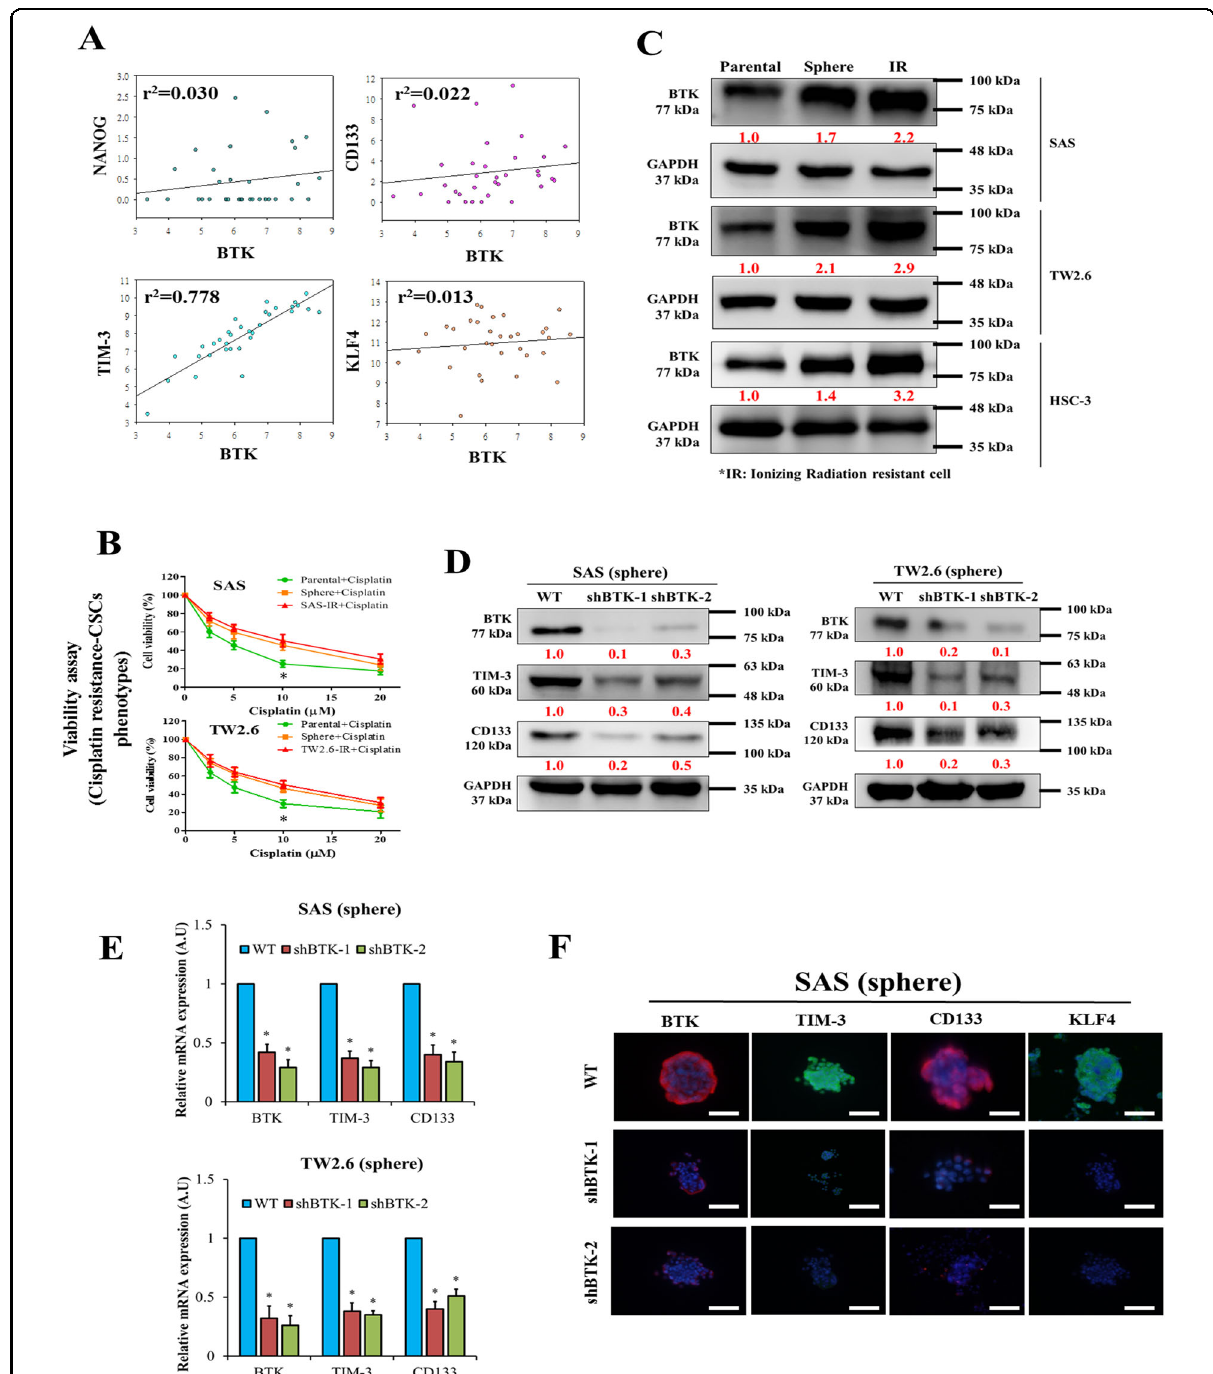
Fig. 2 BTK is positively correlated with radiation-resistant and CSCs-like phenotypes of OSCC. A Scatter plot showing the correlation between the expressions of BTK mRNA and NANOG, CD133, TIM-3, and KLF4. B Cell viability assay revealed higher cisplatin resistance, indicated by sphere and ionizing radiation (IR)-resistant SAS and TW2.6 cells compared with the parental cells. C The protein BTK expression in SAS, TW2.6 and HSC-3 parental, sphere, and IR cell lines as shown by Western blotting. D E Effect of BTK-knockdown on BTK, TIM-3, and CD133 expressions at both mRNA and protein levels. F Immuno fl uorescence staining showing the effect of shBTK on the BTK expression, TIM-3, CD133, and KLF4 proteins in spheres formed by SAS cells. Blue stain = DAPI, nuclear staining. GAPDH is loading control; WT, wild-type. All assays were performed at least twice in triplicate and expressed as mean ± SD. * p < 0.05, ** p <